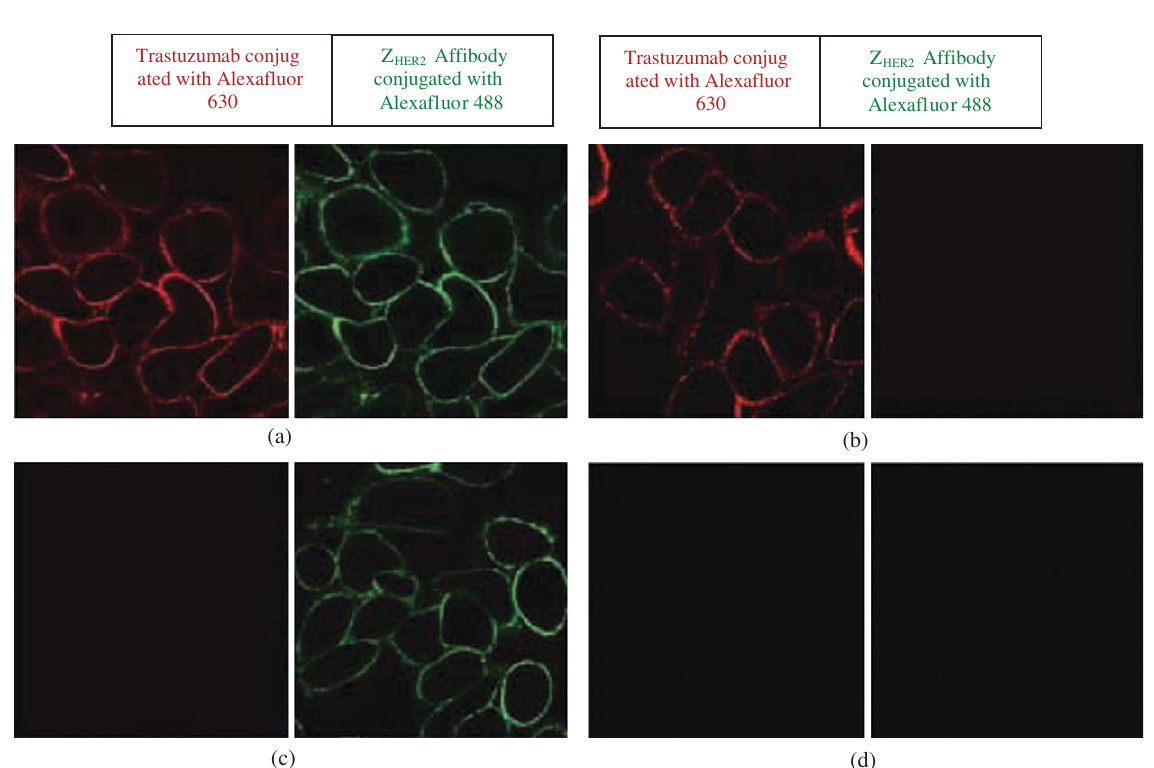
Fig. 8. In-vitro study of binding Affibody (probe) and trastuzumab (MAB drug) to different epitopes of HER2 receptors. (a) Image of SKBR-3 cells after adding the labeled HER2-specific Affibody and labeled trastuzumab to the cell media. (b) Blocking HER2 epitopes with unlabeled 100-fold excess trastuzumab and image of the high HER2 expressing cancer cells after adding the labeled HER2-specific Affibody and labeled trastuzumab. (c) Blocking HER2 epitopes with unlabeled 100-fold excess HER2-specific Affibody molecules and image of the high HER2 expressing cancer cells after adding the labeled HER2-specific Affibody and labeled trastuzumab. (d) Blocking HER2 epitopes with unlabeled 100-fold excess HER2-specific Affibody molecules and unlabeled 100-fold excess trastuzumab and imaging the cells after adding the labeled HER2-specific Affibody and labeled trastuzumab (after